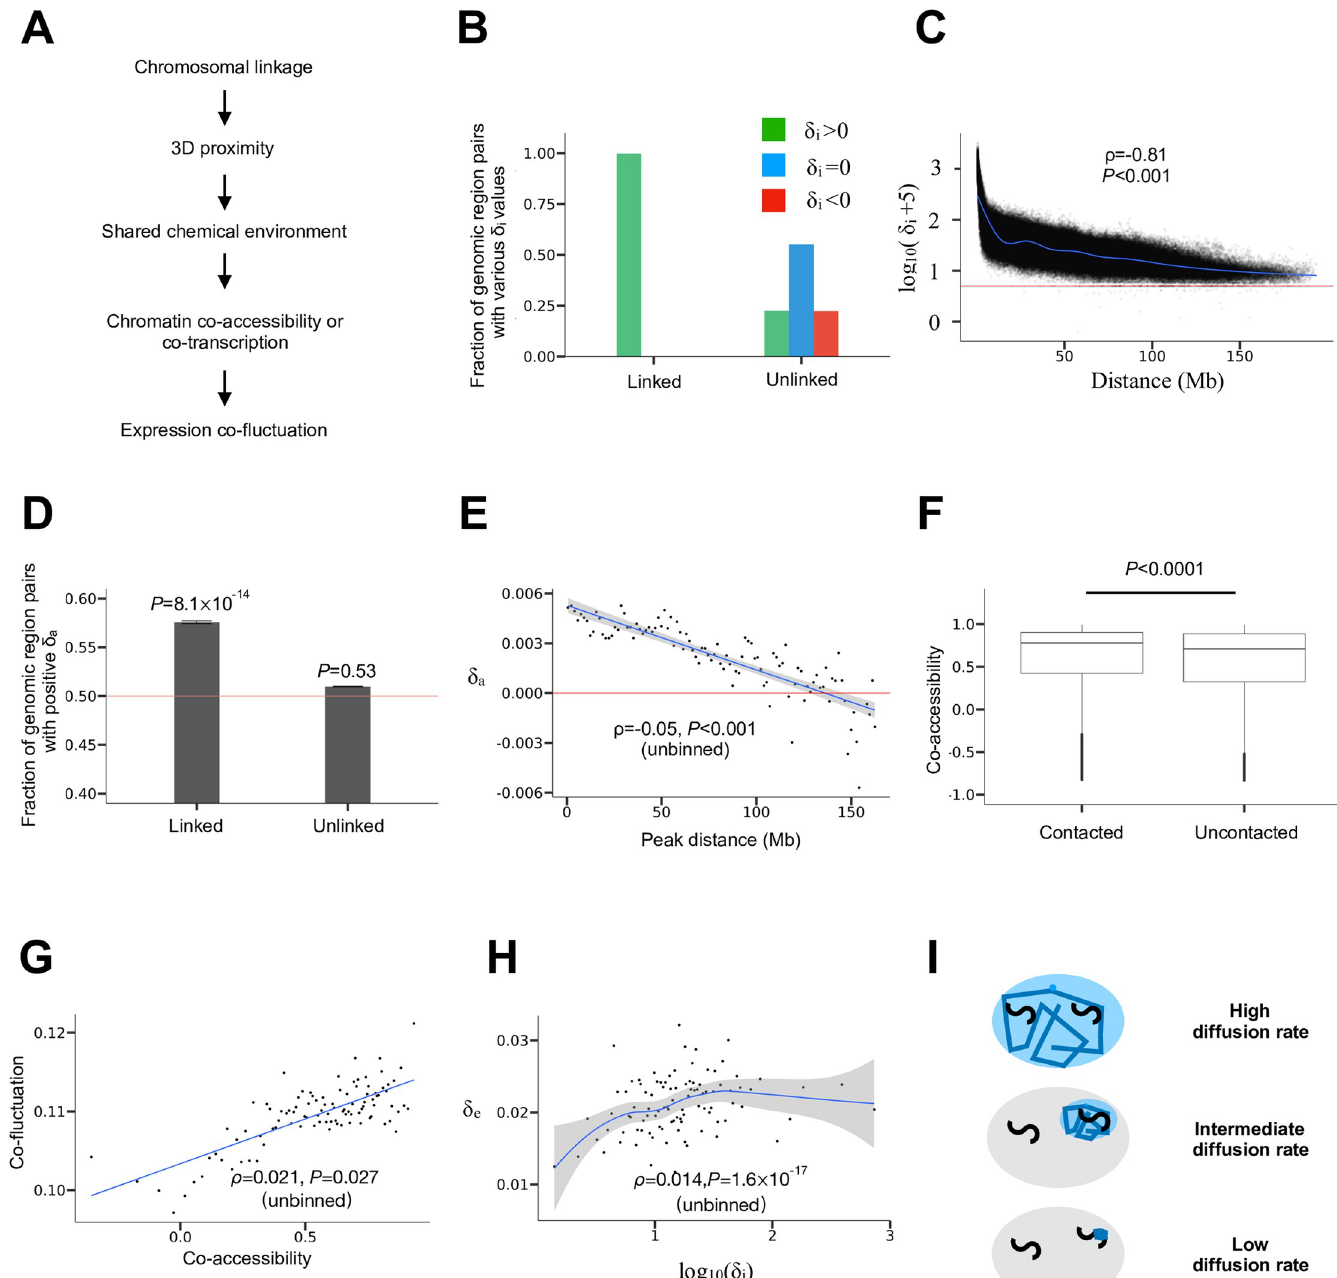
Fig 3. Mechanistic basis of the linkage effect on expression co-fluctuation. (A) A model on how chromosomal linkage causes expression co-fluctuation. (B) Fractions of linked or unlinked genomic region pairs with positive, 0, and negative δ i values, respectively. δ i = (sum of cis -interactions − sum of trans -interactions)/2, where chromatin interactions are based on Hi-C data. All fractions are shown, but the blue and red bars for linked regions are too low to be visible. (C) δ i decreases with the genomic distance between the linked regions considered. Each dot represents one pair of linked genomic regions. Shown here is log 10 ( δ i + 5) because δ i is occasionally negative and it decreases with genomic distance very quickly. The horizontal red line indicates δ i = 0. The blue line is a cubic spline regression of log 10 ( δ i + 5) on the genomic distance. Spearman’s ρ from unbinned data and associated P -value determined by a shuffling test are presented. (D) Fraction of linked or unlinked pairs of ATAC peaks with positive δ a . δ a = (sum of cis -correlations in accessibility − sum of trans -correlations in accessibility)/2. The 95% confidence interval is presented. P - values from binomial tests on independent peak pairs are presented. The red line shows the fraction of 0.5. (E) δ a decreases with the distance between linked ATAC peaks. Each dot represents a bin. All bins have the same distance interval. The red line shows δ a = 0. The blue line shows the linear regression of the binned data and the shade shows the 95% confidence interval of the regression. For better viewing, one bin (X = 156, Y = -0.02) is omitted in the figure; the extreme δ a of the bin is probably due to the small sample size of the bin ( n = 13). Spearman’s ρ computed from unbinned data and associated P -value determined from a shuffling test are presented. (F)